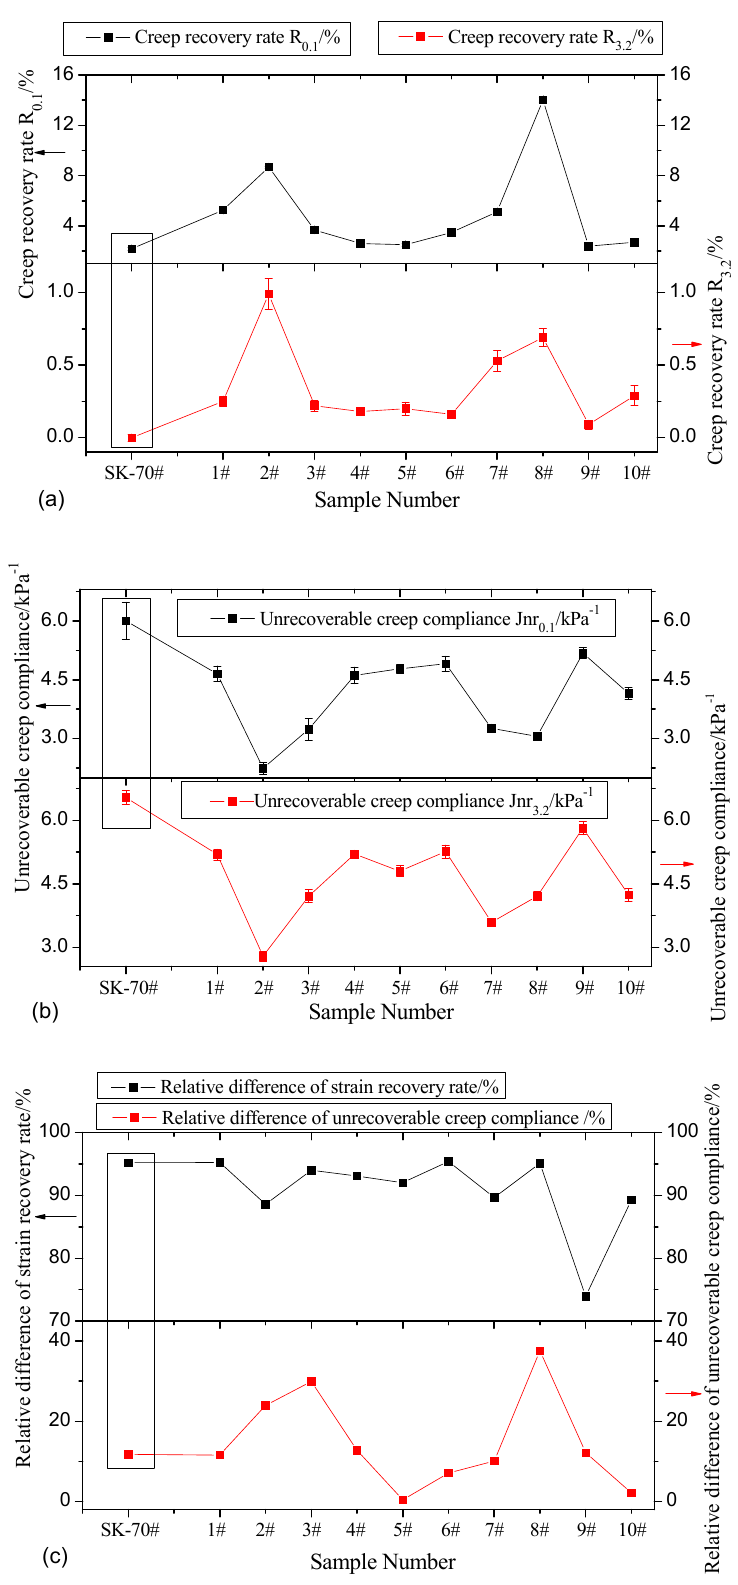
Figure 4. ( a – c ) Creep recovery test